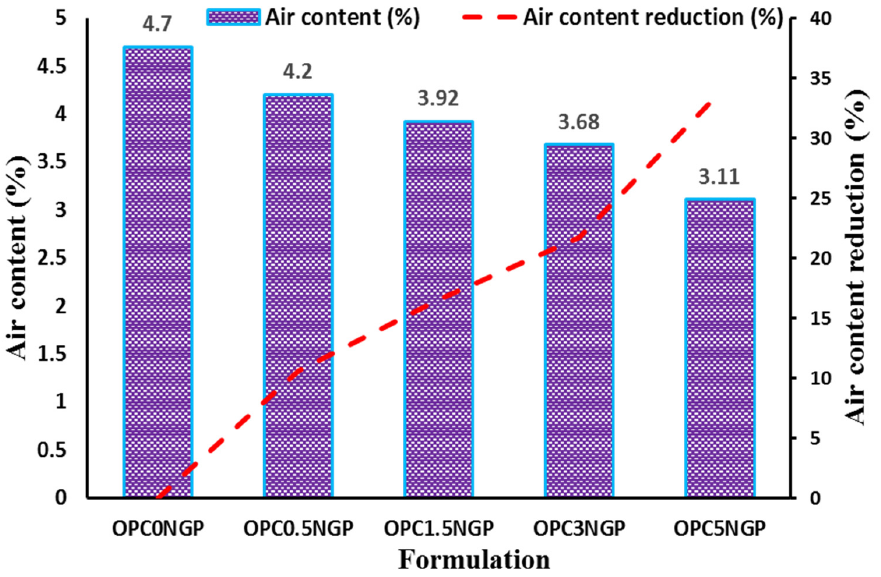
Figure 5. Influence of NGPs on air content (%) of fresh concrete and percentage reduction in air content.